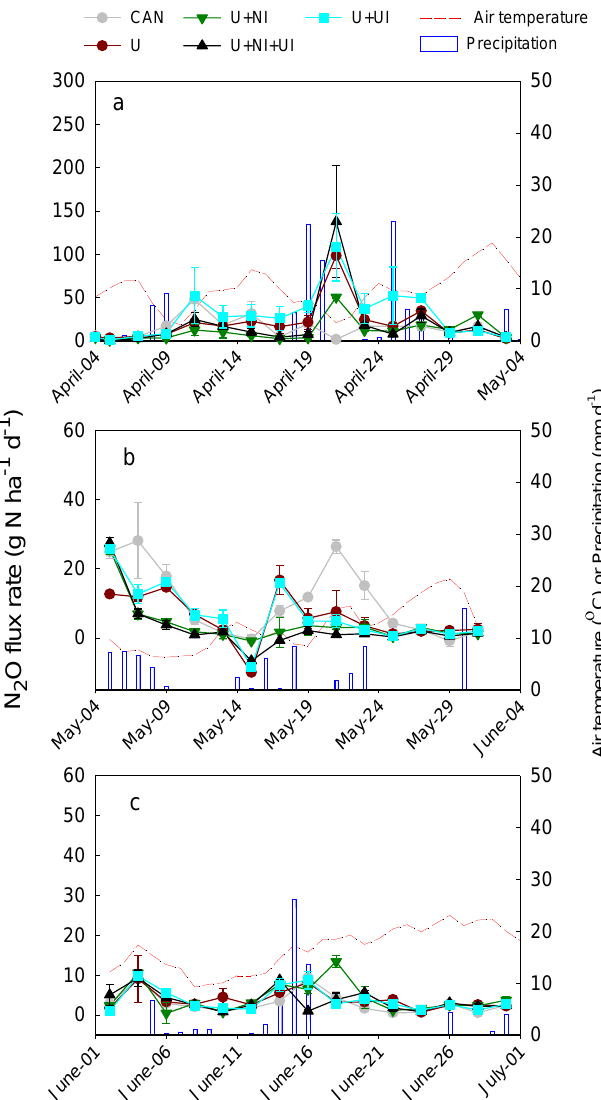
Figure 4. N 2 O flux rate (left vertical axis) and air temperature or precipitation (right vertical axis) for the fertilization treatments (CAN: calcium ammonium nitrate; U: urea; NI: nitrification inhibitor; and UI: urease inhibitor) after the 1st ( a ), 2nd ( b ), and 3rd ( c ) split N application in 2005. The vertical bars indicate the standard deviation of the mean (n = 2).